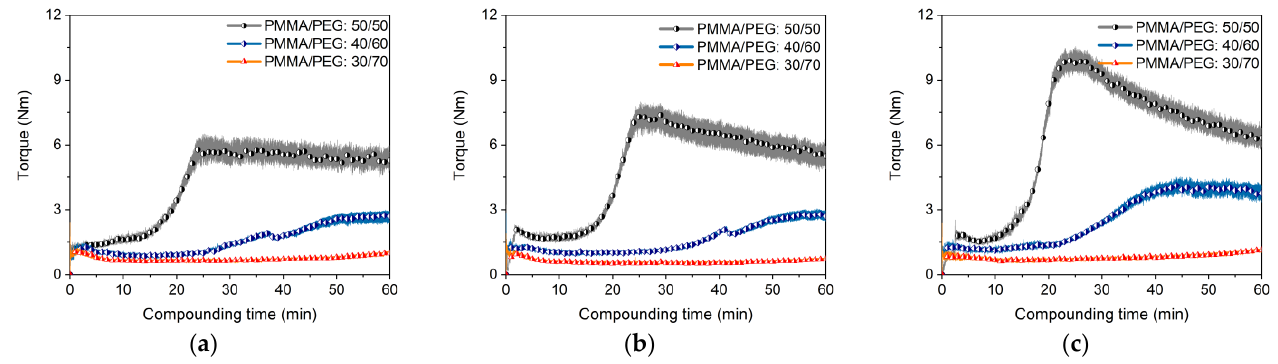
Figure 4. Compounding using different surfactants (5 wt%). ( a ) SA; ( b ) PAT-77P; ( c ) PAT-659/CB.